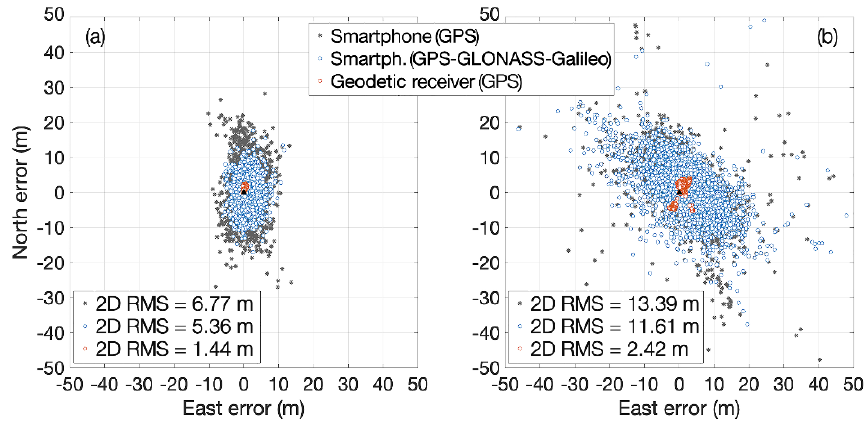
Figure 6. Scatter plot of L1/E1 single-point position error. Grey markers represent errors when the solution has been obtained by using GPS only measurements collected by smartphone, blue circles represent error for smartphone multi-constellation approach, red circles represent error obtained by using geodetic receiver: ( a ) Portici site; ( b ) CDN site.